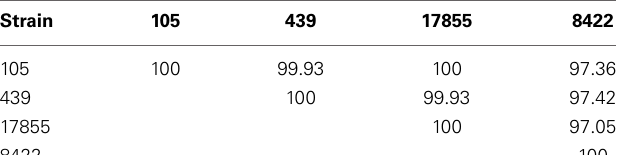
Table 2 | Percent 16S rRNA identities between the B. dorei 105 and 439 genomes described here and the nearly complete genome of B. dorei DSM 17855 and the complete genome of B. vulgatus ATCC